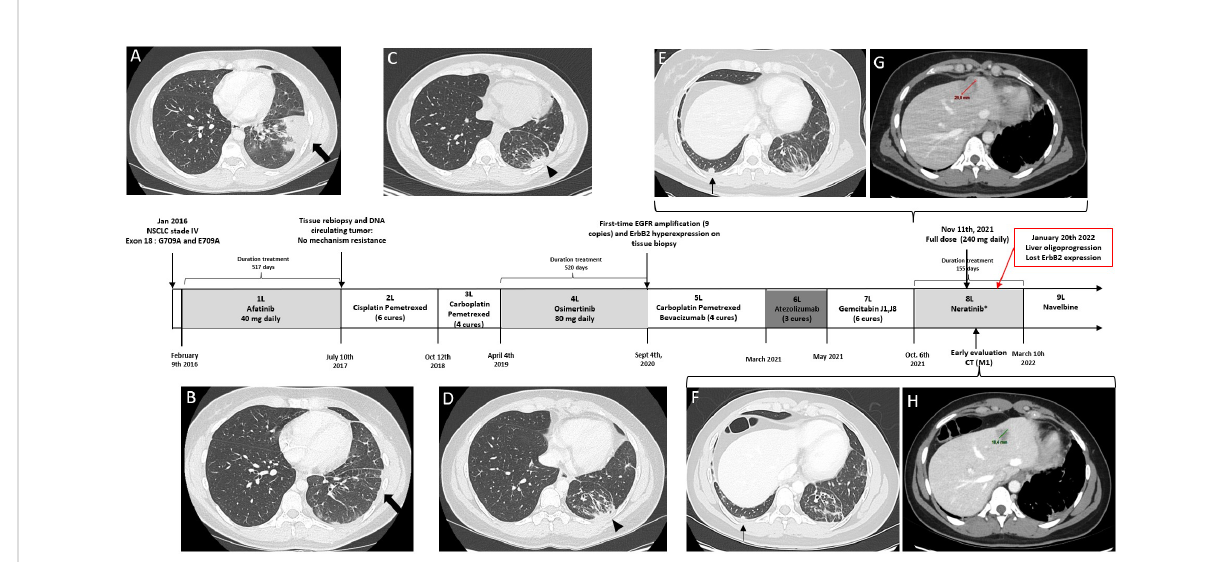
FIGURE 1 Timeline summary with corresponding CT of the different therapeutic lines between February 2016 and November 2021. Baseline chest CT showing (A) a lung mass in the left lower lobe. Best response under afatinib with a partial response ( B , thick arrow). Chest CT before osimertinib ’ s beginning (C) and follow-up CT chest with a stable disease as best response ( D , arrowhead). Baseline chest CT (E) and contrast- enhanced liver (G) CT before neratinib. At 1 month, early assessment showed a partial response of all lung lesions ( F , thin arrow) and liver lesions ( H , a target lesion, 29.8 vs. 18.4 mm, in the longest axis). Red arrow and case: the liver ’ s oligoprogression at second CT evaluation under neratinib and a new liver biopsy was done. Immunohistochemistry showed the loss of ErbB2 hyperexpression. CT, computed